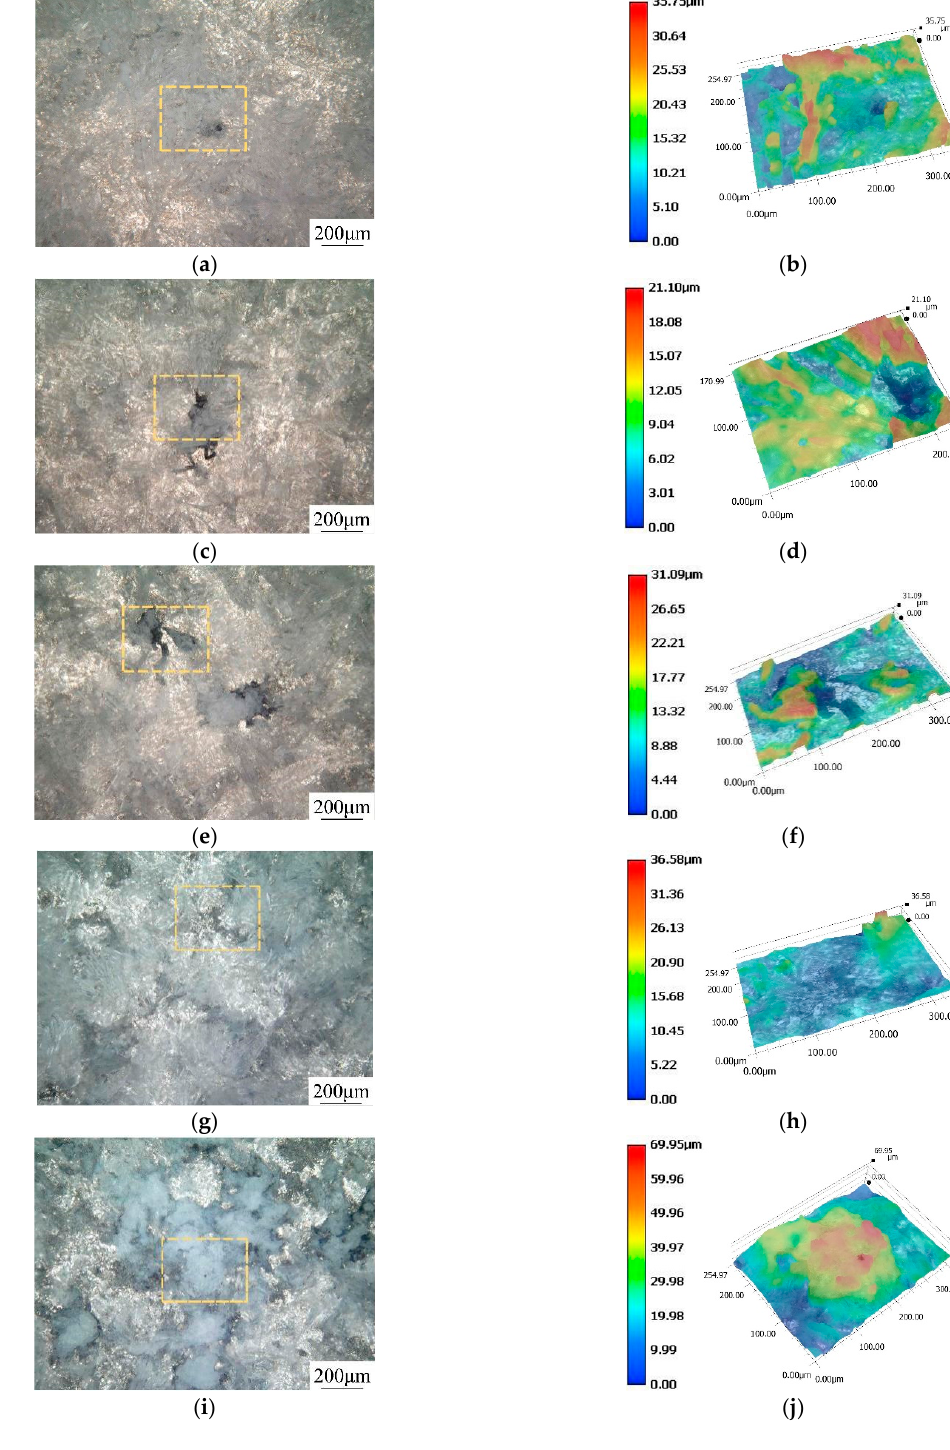
Figure 5. Surface morphologies of C 1 samples after being immersed in 3.5 wt.% NaCl solution for different immersion time: ( a ) 2 h, ( c ) 4 h, ( e ) 6 h, ( g ) 16 h, and ( i ) 24 h. Images ( b ), ( d ), ( f ), ( h ), and ( j ) are the 3D images of the images ( a ), ( c ), ( e ), ( g ), and ( i ), respectively.